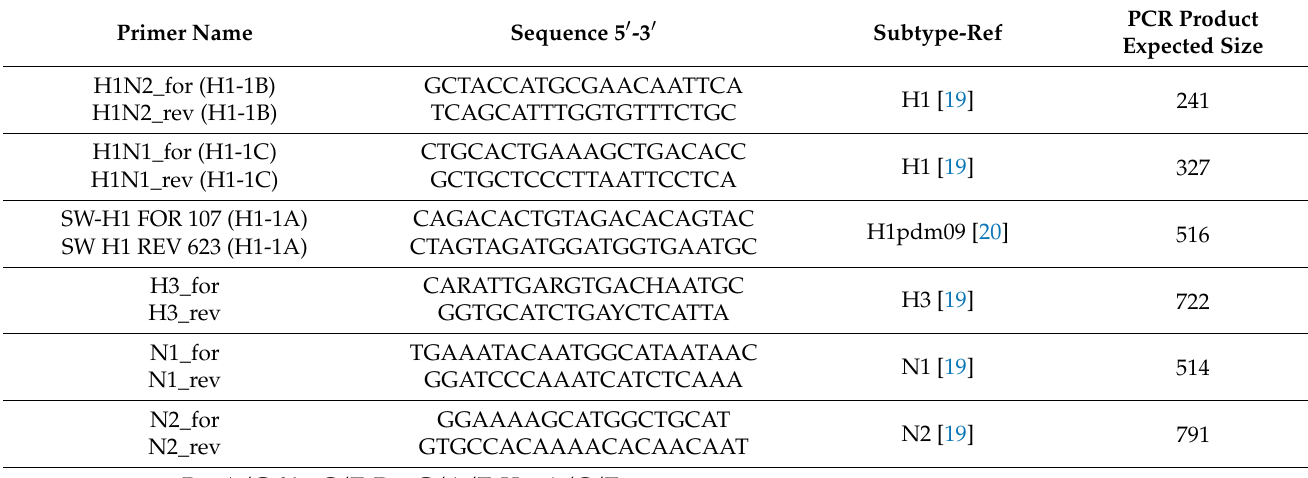
Table 1. List of primers used in the nested multiplex PCR for virus subtyping and PCR product expected